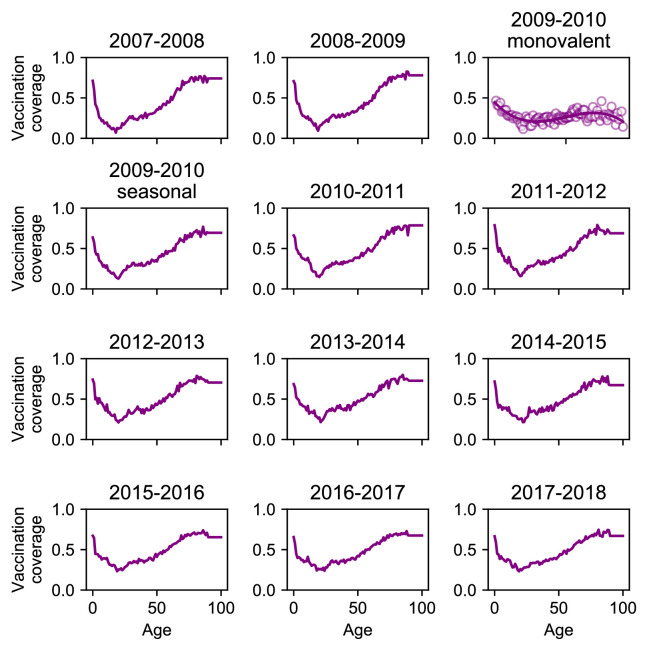
Vaccination coverage.We estimated monovalent vaccination coverage in 2009–2010 by measuring vaccination coverage among enrolled people and fitting a smoothing spline to the data (solid line).